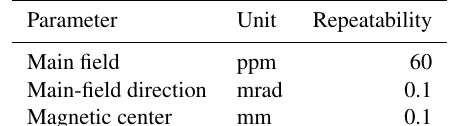
Table 3. The measurement precision of main-field parameters of a single position.